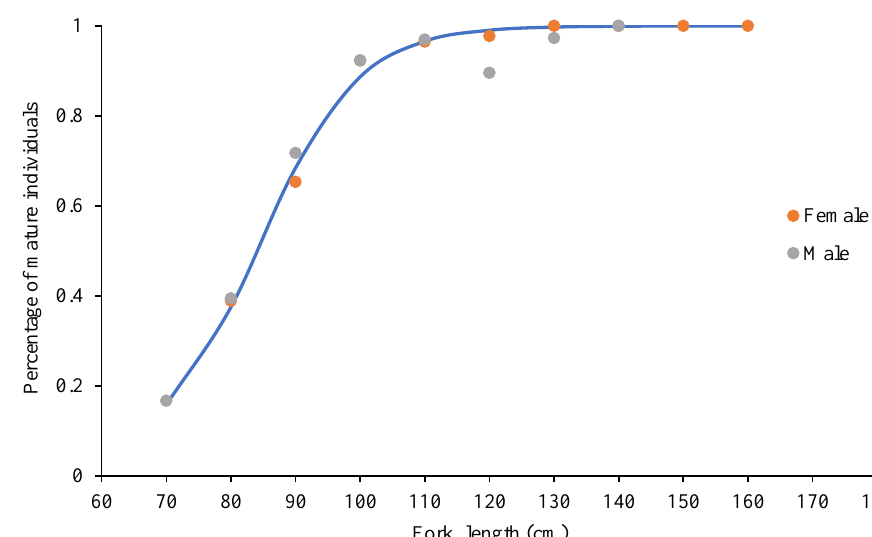
Figure 5. Relationship between percentage of mature individuals and fork length of Acanthocybium solandri in the Western and Central Pacific Ocean.